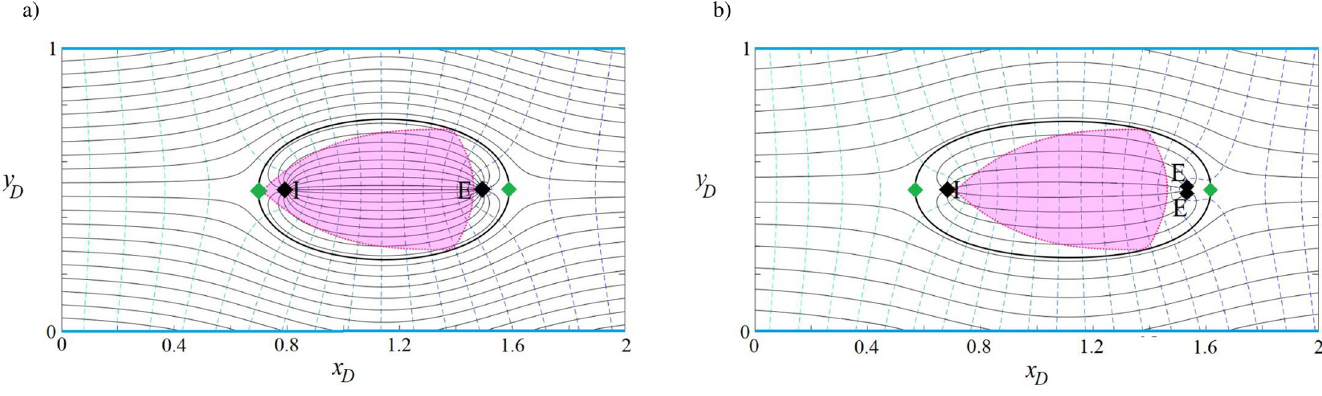
Fig 11. Remediation of groundwater by the pump and treat method a) two-well and b) three-well system. “I” shows the injection wells and “E” the extraction wells. The colored area is the original contaminant plume. The thick black line surrounding the plume is the dividing streamline that defines the capture zone that separates the plume from the rest of the aquifer and β = 0.